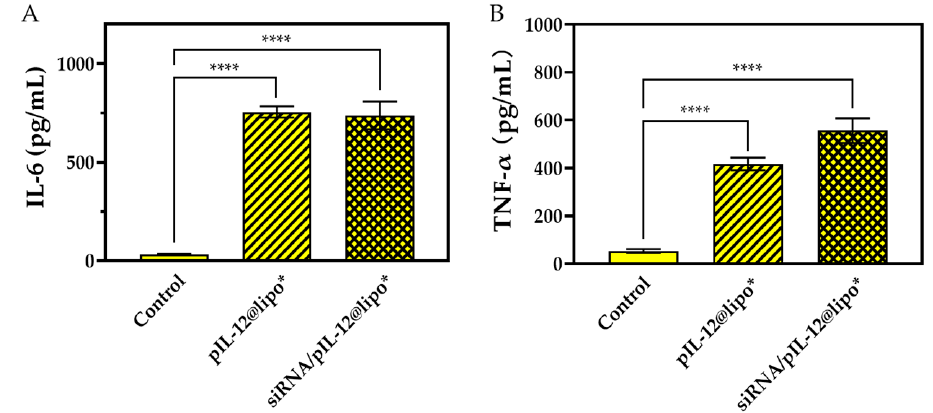
Figure 9. The concentrations of IL-6 ( A ) and TNF- α ( B ) in the culture supernatant of J774A.1 cells treated with pIL-12-containing complexes for 48 h at the siRNA concentration of 300 pmol/mL and/or the pIL-12 concentration of 5 µ g/mL. J774A.1 cells without treatment were used as a control (**** p < 0.0001; n = 3).